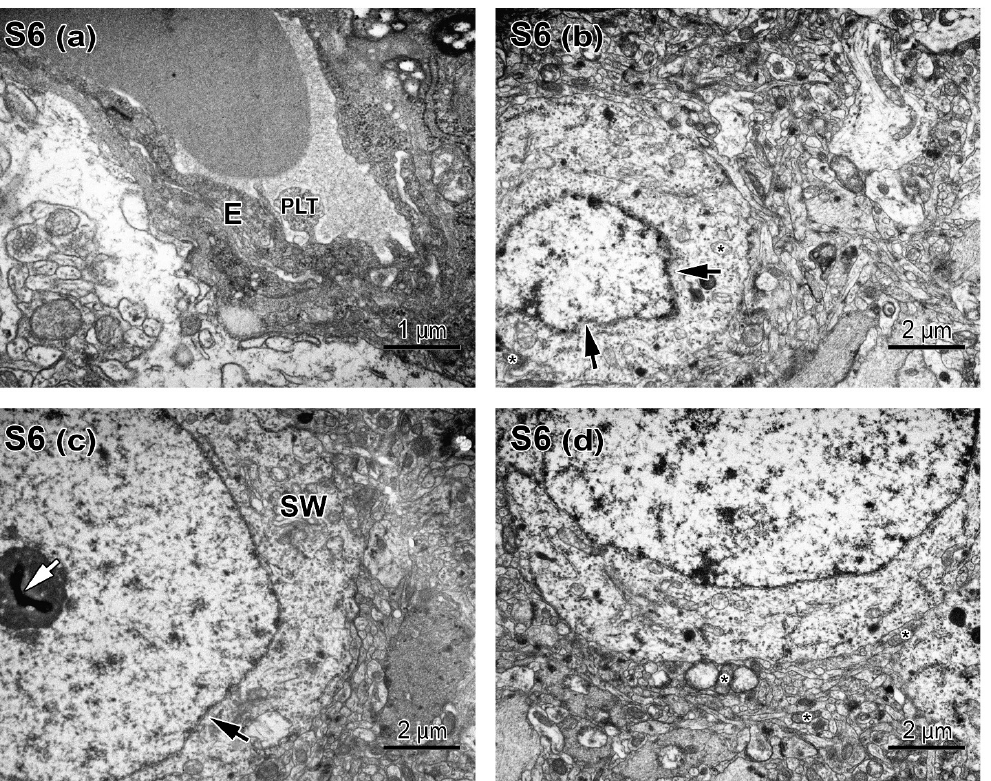
Figure 9. Electron micrographs showing the polyvalent changes in the CA3 area induced by 6 days of repeated restraint stress; ( a ) Platelet (PLT) adherent to endothelium wall (E) surrounded by perivascular lysis, which alters the transfer between astrocyte end-foot and capillaries; Original magnification ×12,000; ( b ) Neuron with irregular nuclear shape (black arrows) and near-normal mitochondrial aspect (asterisk); ( c ) CA3 neuron with slight irregularities in nuclear contour (black arrow) with cytoplasm swelling (SW) and condensed nucleolus chromatin (white arrow); ( d ) CA3 neuron with normal aspects of the mitochondria (asterisk) after 6 days of repeated stress; Original magnification ×6000.